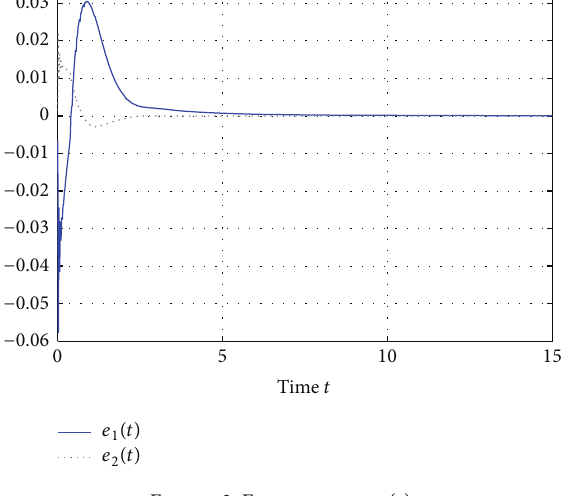
Figure 3: Error response 𝑒(𝑡) .